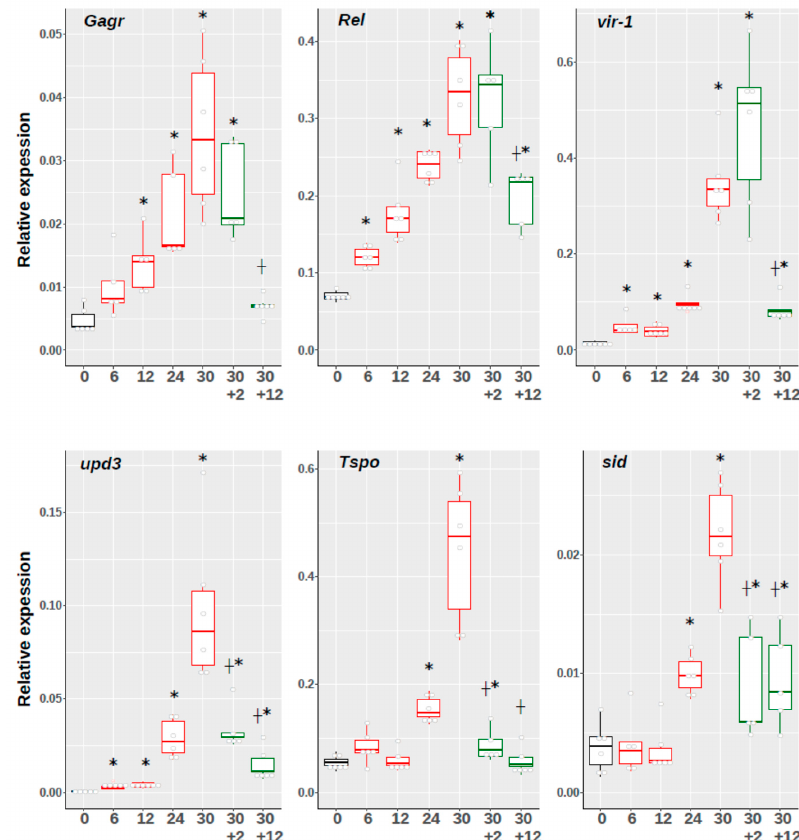
Figure 4. Relative expression of Gagr and stress-induced genes in D. melanogaster females in response to different times of exposure to 0.1 M ammonium persulfate and after 30 h exposure followed by 2 or 12 h recovery periods. The horizontal axis shows the exposure time, 2 and 12 h recovery periods are marked on the axis as “30 + 2” and “30 + 12”. * - significant differences relative to the basal level, │ - significant differences after the recovery period relative to the level after 30 h (Mann-Whitney test, p - value < 0.01, N = 5–6). The data are presented as scatterplots and boxplots (median, interquartile range, 5 to 95 percentile).